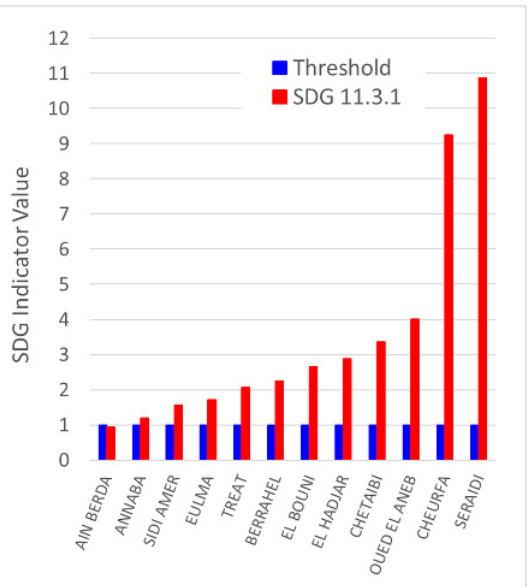
Figure 18. SDG 11.3.1 indicator values for the communes in the Annaba wilaya. The constant blue bars represent the value over which the commune develops away from sustainability.